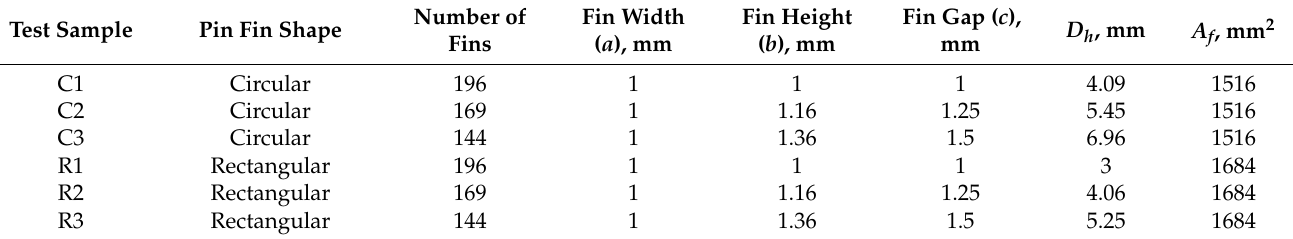
Table 1. Configuration and dimensions of the test samples.